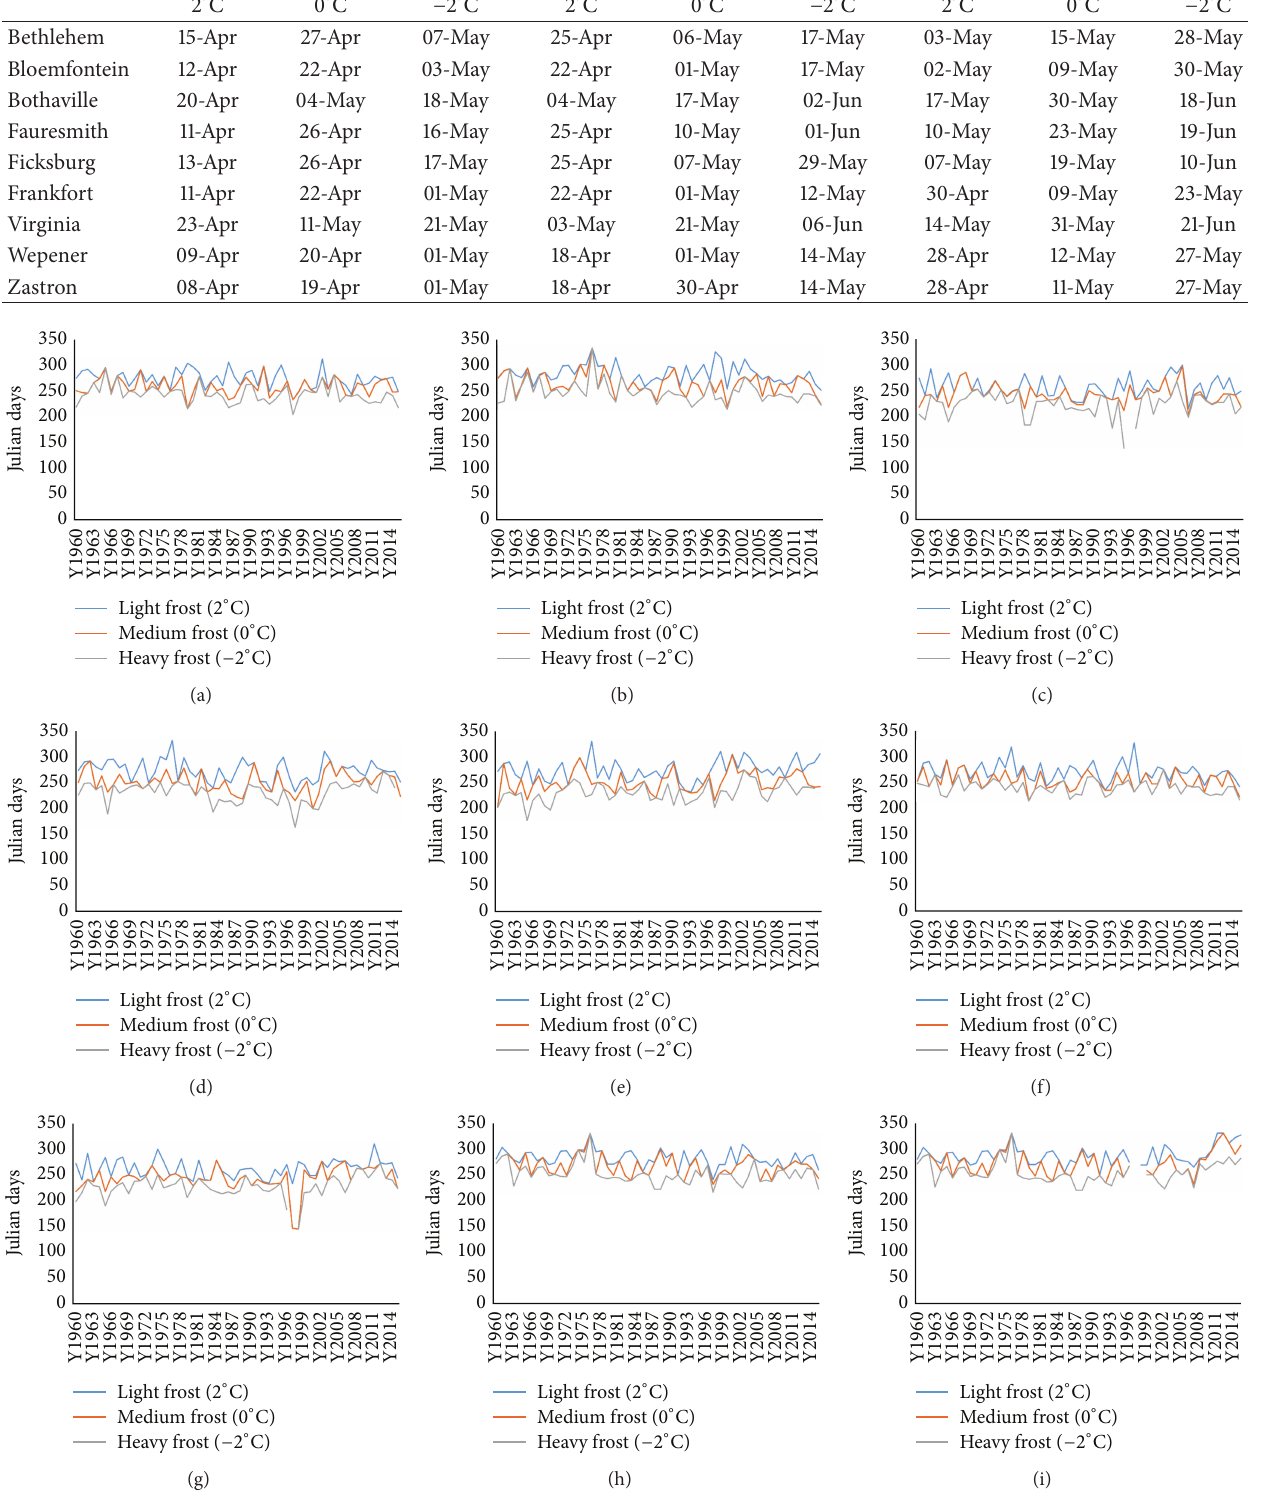
Figure 3: Time series of cessation of frost in Julian days from 1960 to 2015 for (a) Bethlehem, (b) Bloemfontein, (c) Bothaville, (d) Fauresmith, (e) Ficksburg, (f) Frankfort, (g) Virginia, (h) Wepener, and (i)